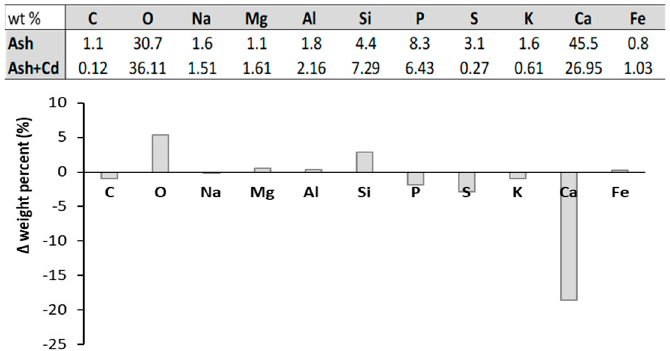
Figure 12. Changes in the elemental composition of poultry ash. Δ weight percent indicates the difference in the content of an individual element before and after Cd adsorption. A positive Δ weight percent value indicates an increase in the wt% content of a given element, whereas a negative value indicates a decrease in its wt% content.